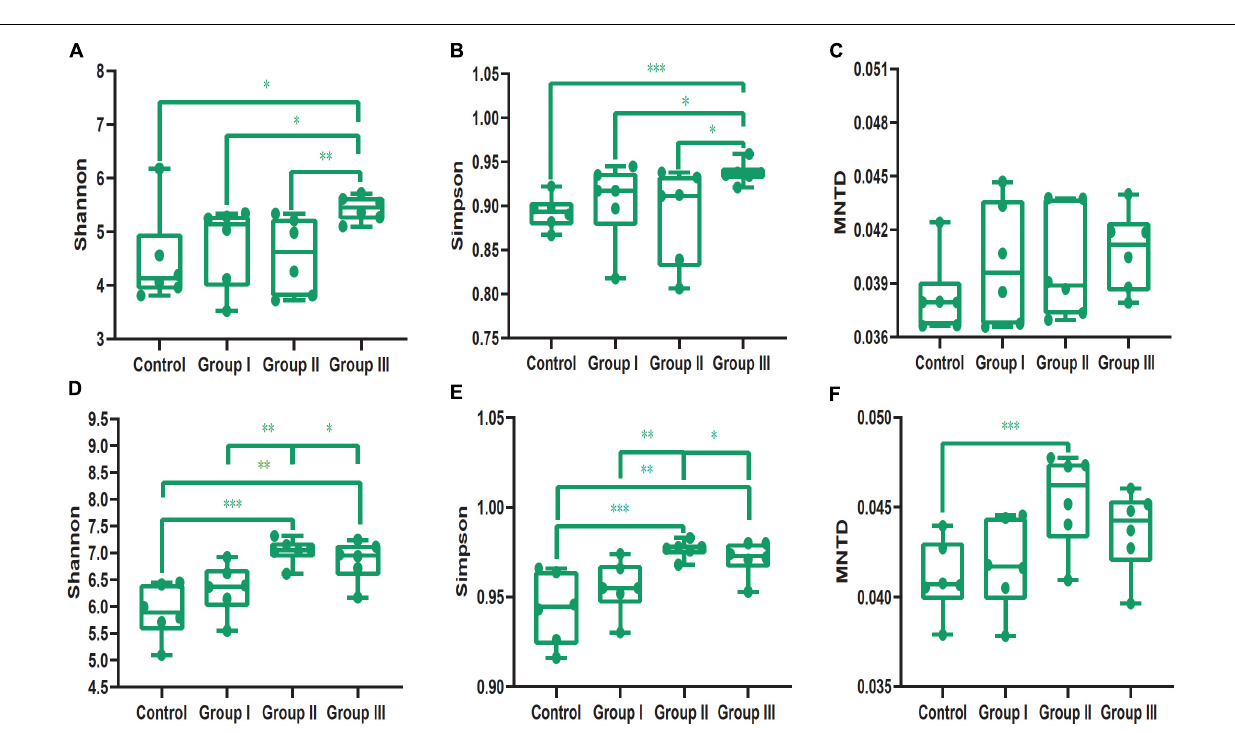
III, P = 0.002) and Simpson (Wilcoxon, Control vs.